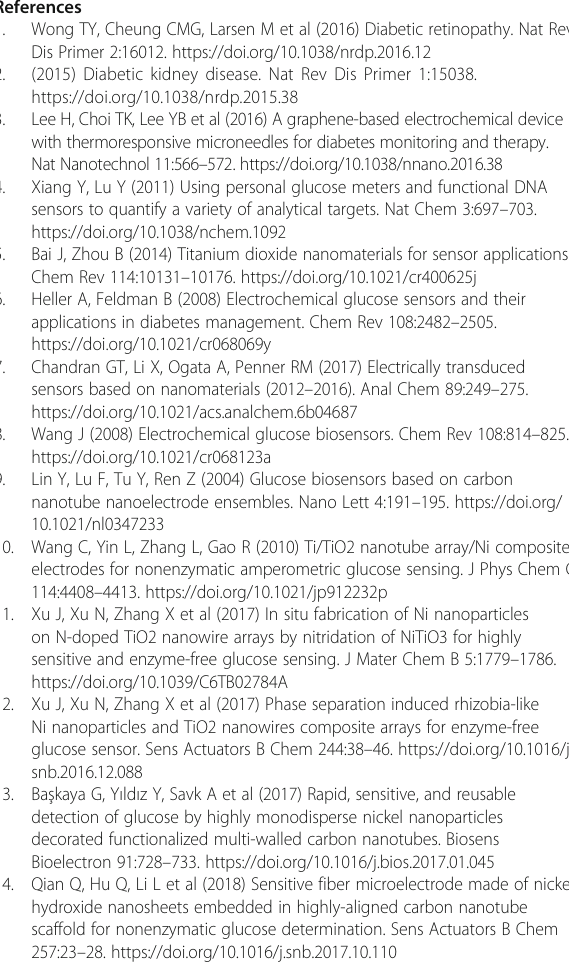
Additional file 1: Figure S3. Another important observa-